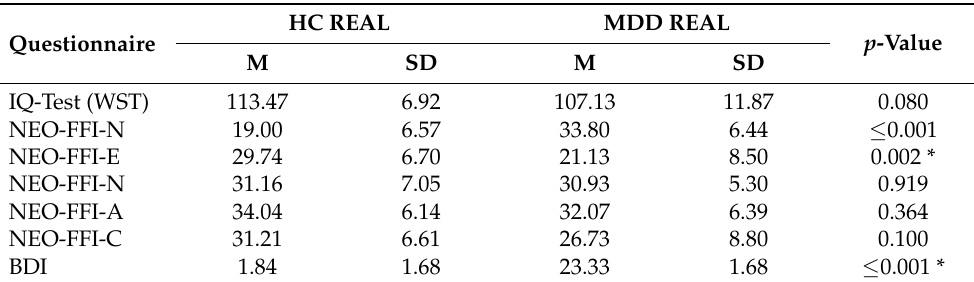
Table 2. Comparison of psychometric data between healthy controls (HC REAL) and depressive patients (MDD REAL) before NF.